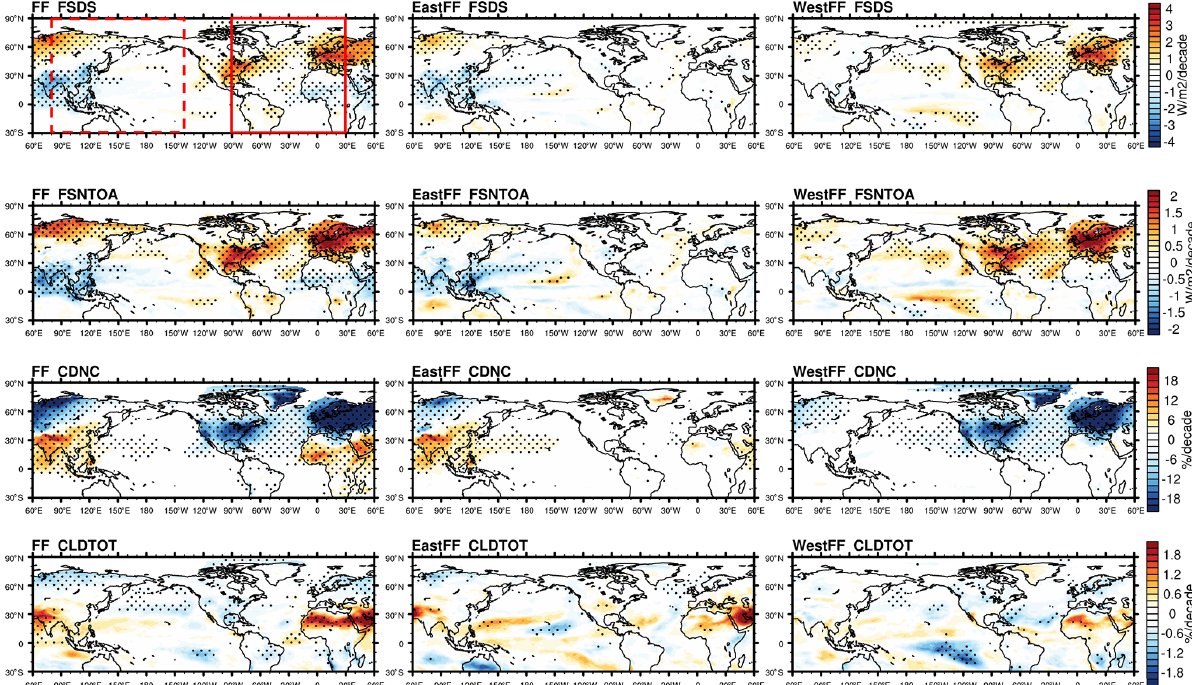
Figure 4. The first row shows 40-year trend in surface downward solar flux (FSDS; Watts per square meter per decade; hereafter Wm − 2 per decade) in response to FF (left), EastFF (mid), and WestFF (right). The second row shows the top-of-atmosphere net solar flux (FSNTOA; Wm − 2 per decade), the third row shows the vertically integrated droplet number concentration (CDNC; percent per decade), and the fourth row shows the total cloud fraction (CLDTOT; percent per decade). The CDNC and CLDTOT patterns show the percentage trend relative to the 40-year climatology. Dotted areas indicate the region where the trend passes the 95% significance test. The high-latitude ocean regions with significant sea ice change (e.g., the Arctic and the Sea of Okhotsk) are masked to remove the surface albedo change effects. The dashed box in the left panel of first row indicates the Eastern Hemisphere (EH box; 80 ◦ E–140 ◦ W) used in our subsequent analysis, and the solid box indicates the Western Hemisphere (WH box; 90 ◦ W–30 ◦